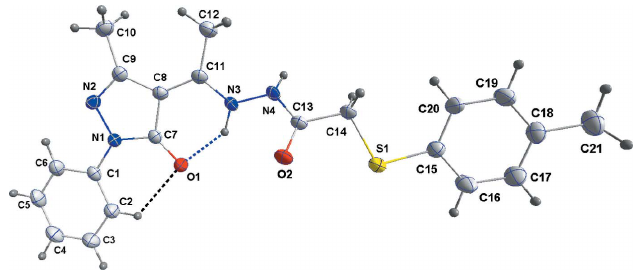
Table 1 Hydrogen-bond geometry (A˚ , (cid:2)